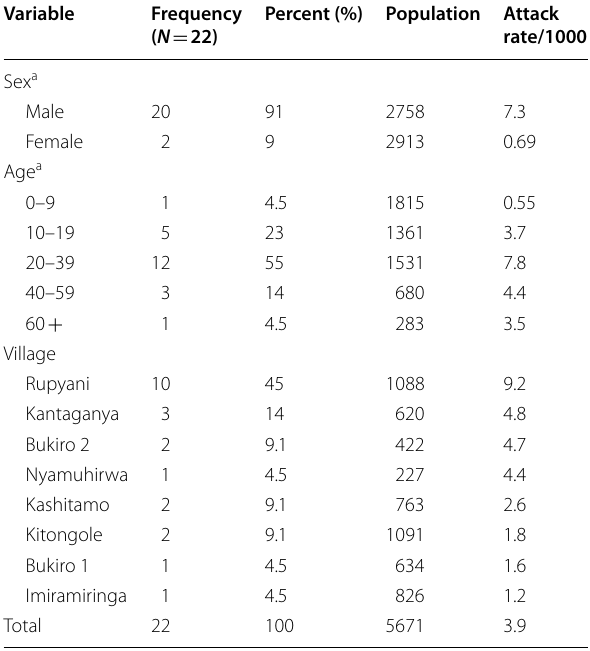
a Sex- and age-specific populations were estimated based on age distribution in Engari subcounty